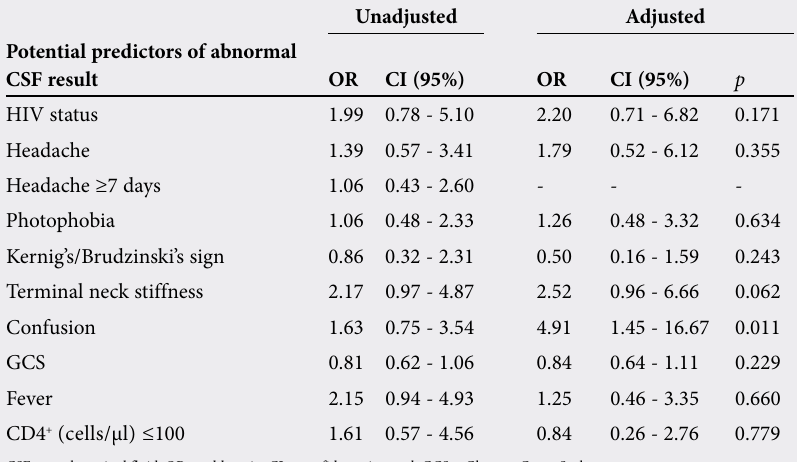
CSF = cerebrospinal fluid; OR = odds ratio; CI = confidence interval; GCS = Glasgow Coma Scale.